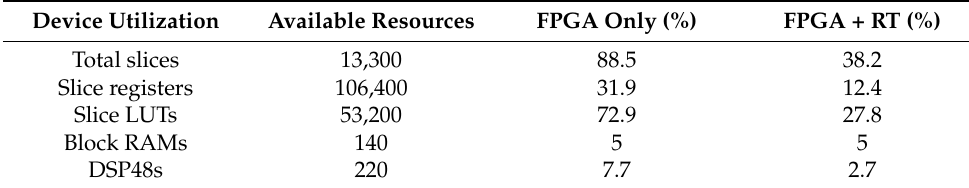
Table 2. Comparison of the control algorithm computational costs.